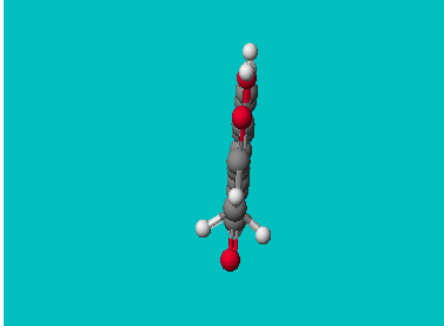
Figure 1. PM5 geometry of 3-acetyl-4-hydroxy-chromene-2-one ( 1 ).